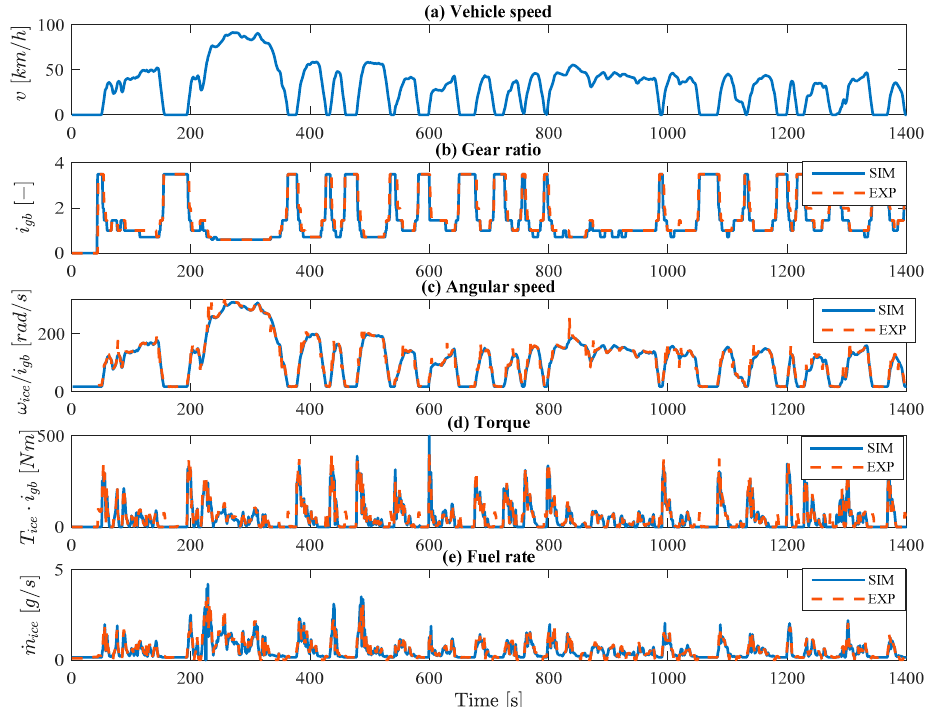
Figure 13. Comparison of results of simulation and experiments. ( a ) vehicle speed profile; ( b ) gear ratio of the gearbox; ( c ) ICE angular speed at the gearbox output; ( d ) the engine torque at the gearbox output; and ( e ) the fuel consumption rate. SIM—Simulation, blue line, EXP—Experiment, orange dashed